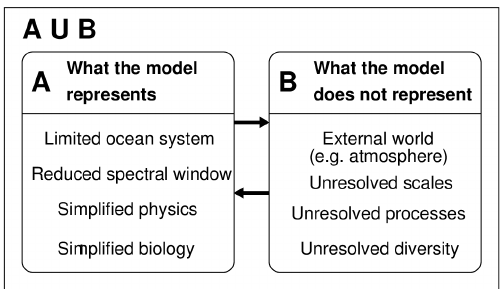
Figure 1. Schematic of the separation between resolved and unre- solved processes (systems A and B ). Even if A ∪ B can be assumed deterministic, system A alone is not deterministic in general, be- cause of the interactions with system B